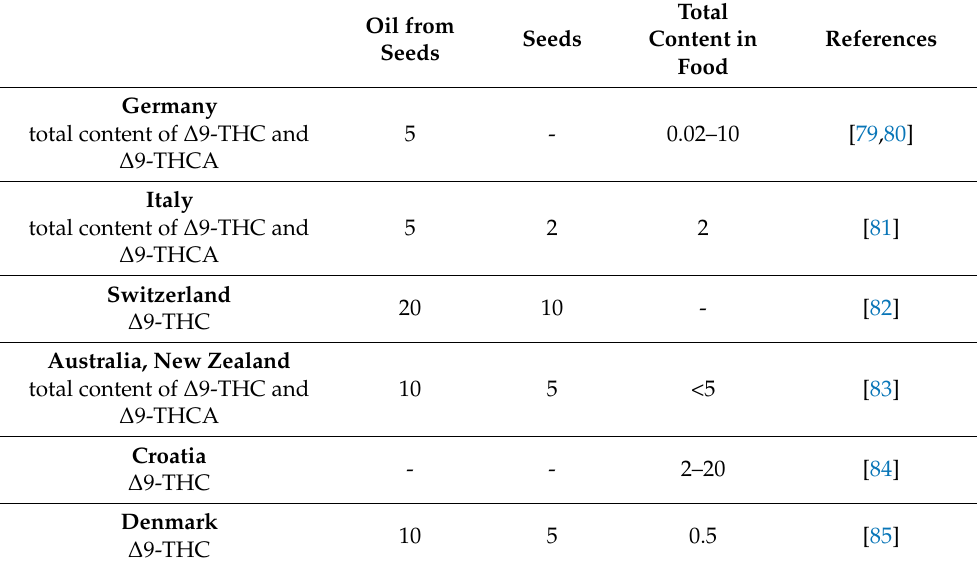
Table 3. Limitation of ∆ 9-THC content in food (ppm).